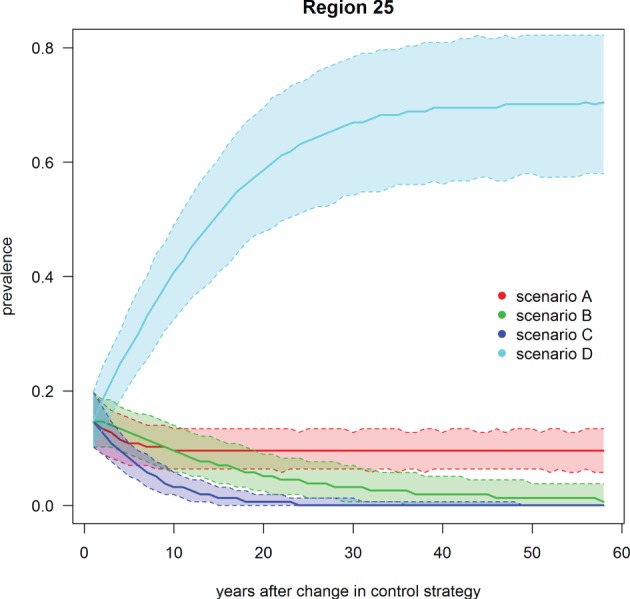
Trend of footrot prevalence for the four different scenarios A–D for region 25 (example for a region with mandatory control program). Lower dashed line = 2.5‰, upper dashed line = 97.5‰, solid line = median out of 1,000 simulations.